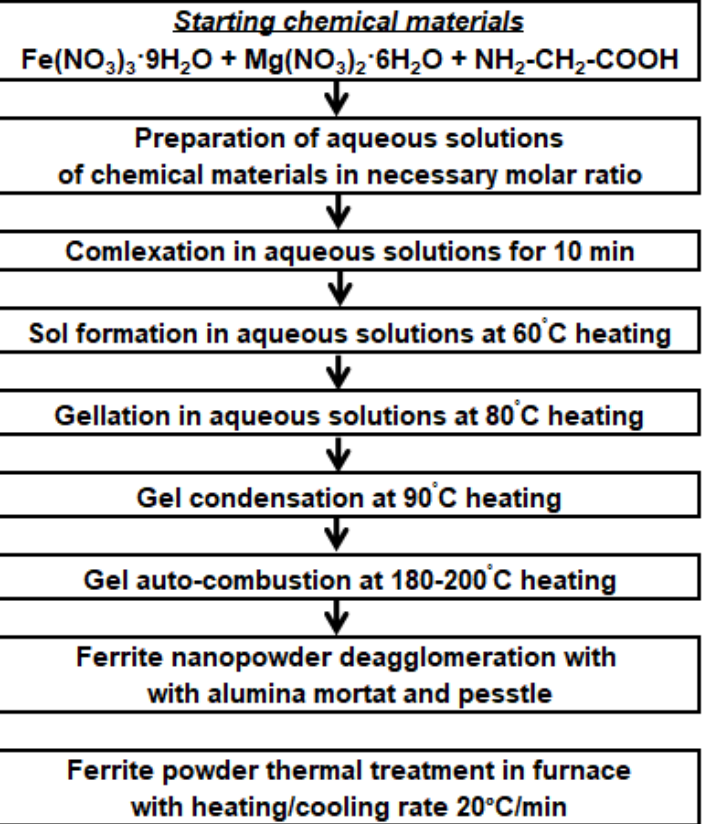
Figure 1. Flow chart to synthesize MgFe 2 O 4 nanopowder. Phase evolution of produced MgFe 2 O 4 powder samples was analyzed by a Shi- madzu XRD-7000 X-ray diffractometer (Japan) using monochromatic Cu-Ka radiation ( λ = 0.154056 nm) at room temperature in Bragg–Brentano geometry in the range of angles 2 θ from 20 ◦ to 70 ◦ with a scanning step—0.05 ◦ and a spectrum acquisition time of 1 s per point to obtain diffractograms. The average nanocrystallite size in the samples was also calculated from the width of all observed XRD peaks using Scherrer’s equation: D hkl = k λ / β hkl cos θ where D hkl is the average crystallite size, the coefficient k is 0.9 (for a cubic structure of spinel ferrite), λ is the X-ray wavelength used, β hkl is the intrinsic full width at half maximum of the diffraction line profile, and θ is the position of the principal diffraction peak. The identification of diffraction reflections and the search for crystalline phases in the samples were carried out using the computer program Profex 4.0.0 (Nicola Döbelin, Solothurn, Switzerland) and XPowderX software (ver 2018) (J. Daniel Mart í n-Isl á n, Granada, Spain). The density of produced MgFe 2 O 4 ferrite nanoparticles was determined by the X-ray diffraction method by analyzing the obtained data structural parameters, including the crystal lattice